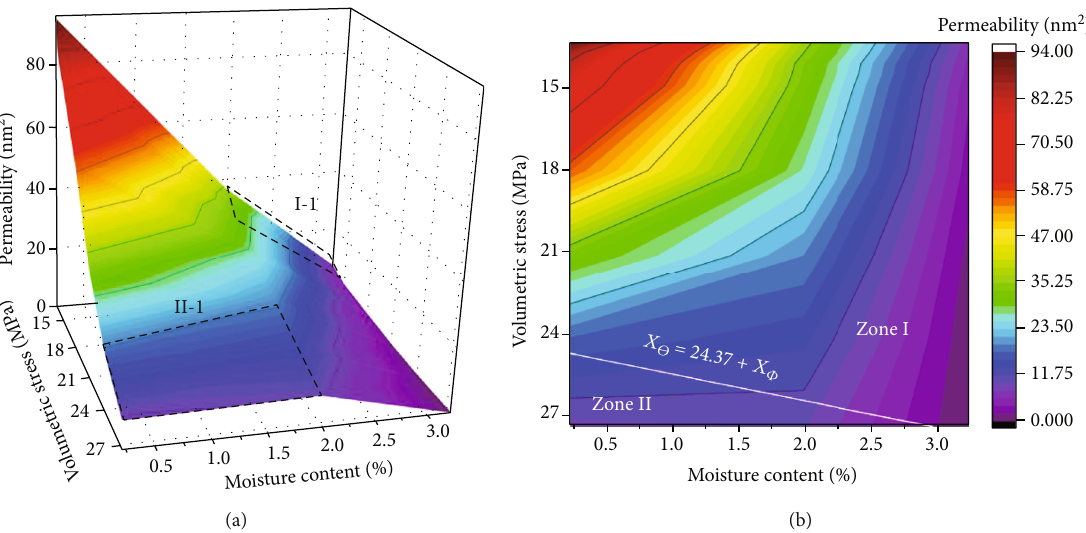
Figure 12: Division of sensitive regions under the test conditions: (a) Three-dimensional diagram of Figure 10; (b) Top